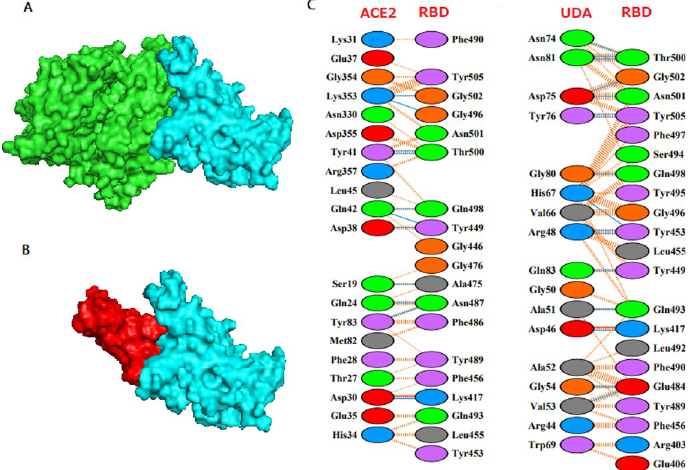
Fig 2. a RBD-ACE2 X-ray crystallography (PDB ID: 6glz).ACE2 is shown green, and RBD is shown cyan. b UDA– RBD docked complex. RBD is shown cyan, and UDA is shown red. c Analyzing various interactions in RBD-ACE2 and RBD-UDA using PDBsum